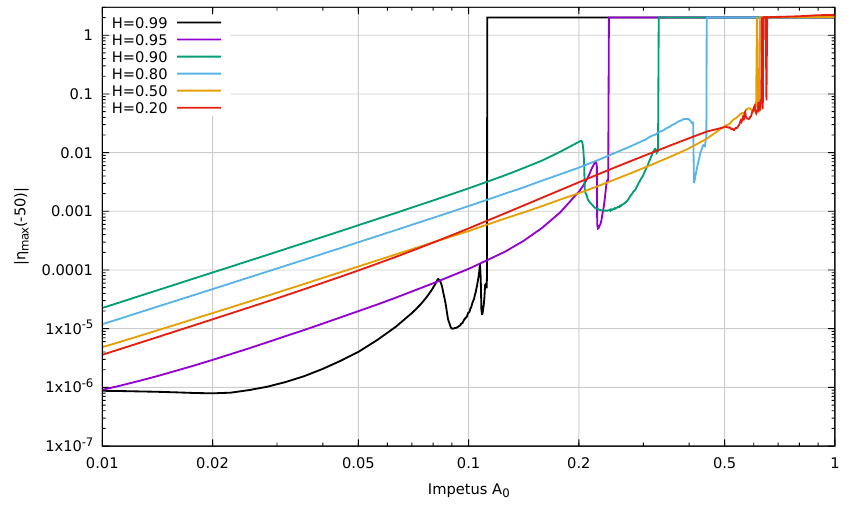
Figure 14 . A log-log plot of the maximal radiation amplitude at x = (cid:0) 50 for the kicked initial conditions (cid:30) ( x; 0) = (cid:30) 1 ( x ), (cid:30) t ( x; 0) = A 0 ! B (cid:17) B ( x ) as a function of A 0 . Note that for small A 0 and H < H 2 the power law decay rate is